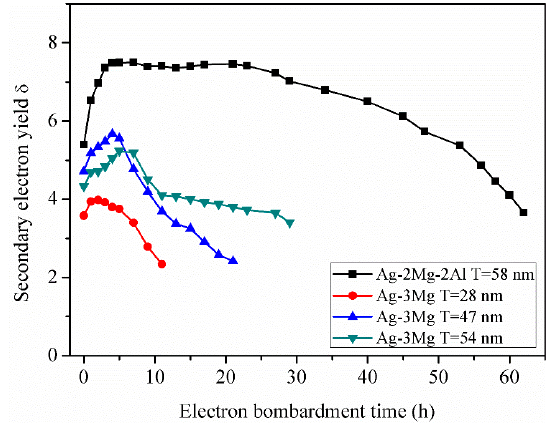
Figure 8. Secondary electron yield over time for the Ag-3Mg and the Ag-2Mg-2Al alloys with different thicknesses of surface films (T) under constant bombardment by energetic electrons of 600 eV and at a current density of 5 mA cm − 2 .